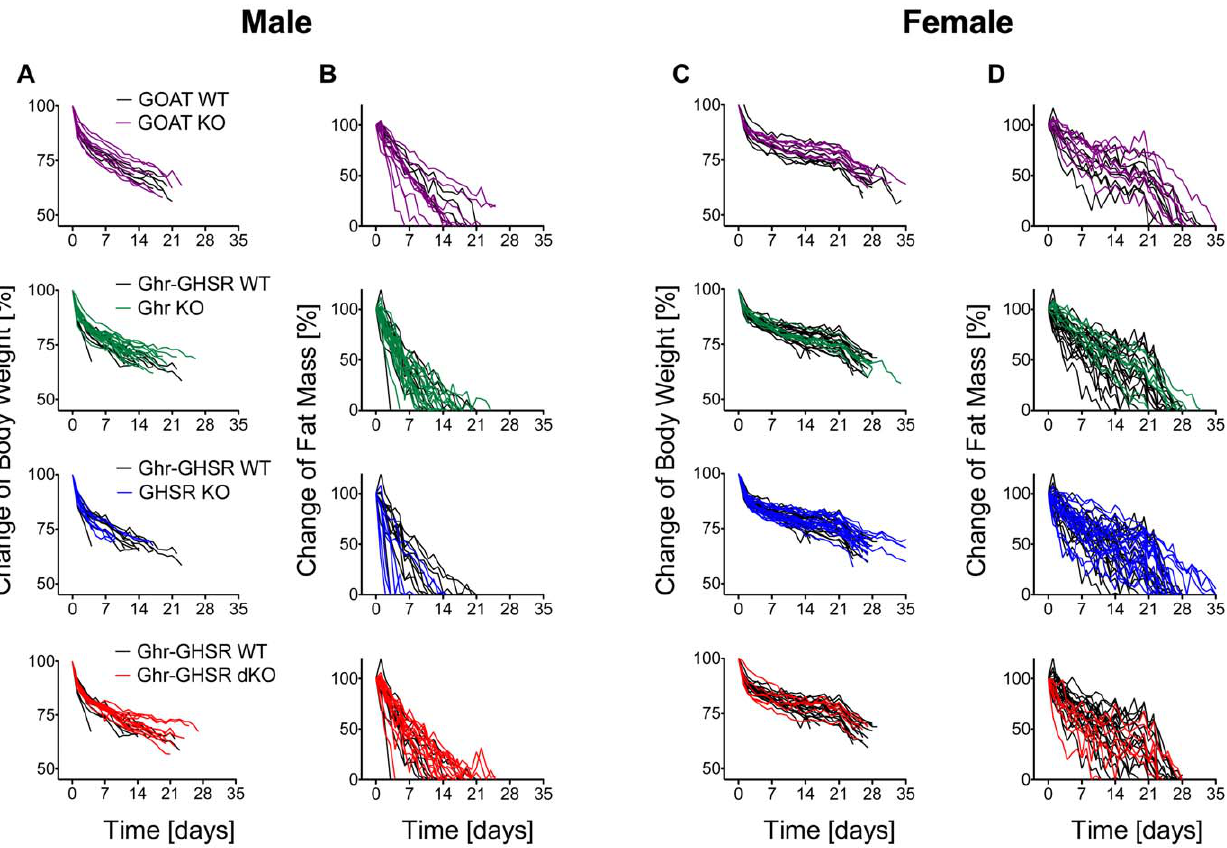
Figure 1. Change of body weight and fat mass in WT and ghrelin-loss-of-function mice after chronic CR. Male (A,B) and female (C,D) wildtype (WT) and GOAT, Ghrelin (Ghr), GHSR, or Ghr-GHSR dKO mice were subjected to chronic CR (40% of ad libitum calories), and changes in body weight (A,C) and fat mass (B,D) were recorded. Values are shown for each individual animal. Mice were taken out of the CR regiment when fat mass dropped to 0% for 2 consecutive days, or when mice became severely hypoglycemic. Lines depict body weight and fat mass curves for individual animals from groups of 8 male GOAT WT, 5 female GOAT WT, 9 male GOAT KO, 8 female GOAT KO, 10 male Ghr-GHSR dWT, 20 female Ghr-GHSR dWT, 19 male Ghr KO, 18 female Ghr KO, 7 male GHSR KO, 19 female GHSR KO, 16 male Ghr-GHSR dKO and 7 female Ghr-GHSR dKO mice.